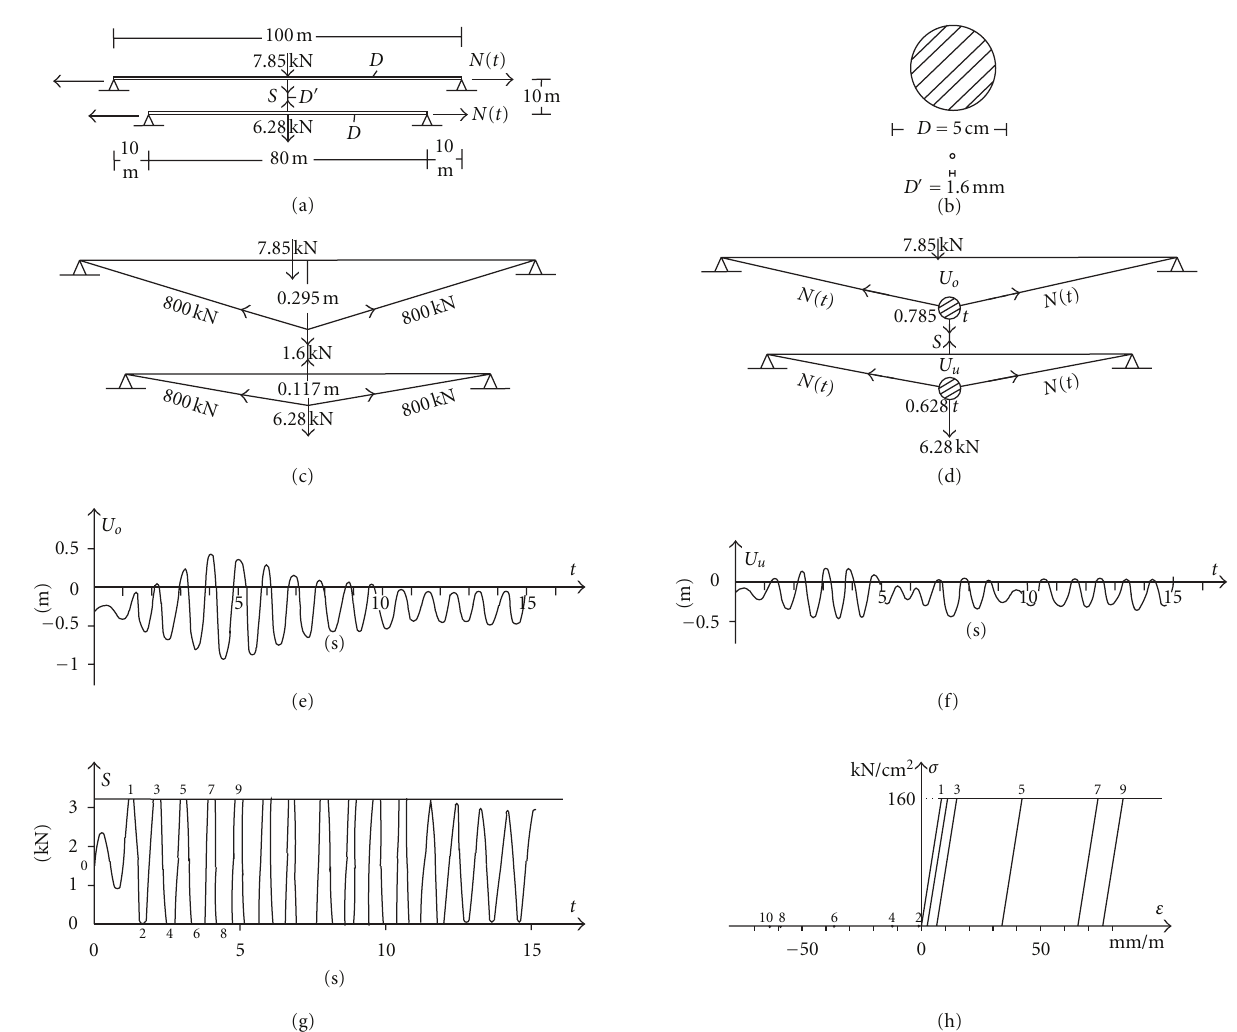
Figure 4: Second application: couple of interconnected cables, subject to tra ffi c. (a) Given geometry and loading. (b) Crosssections of main cables and cross-tie. (c) Initial static analysis. (d) Parameters of dynamic analysis. (e), (f) Resulting time-histories of vertical displacements of centers of upper and lower cables. (g) Resulting time-history of axial force of cross-tie. (h) Resulting hysteresis stress-strain loops of the